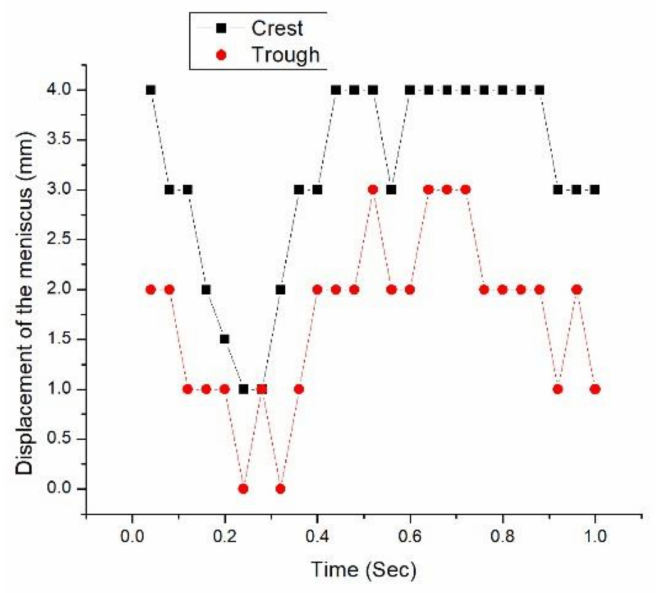
Figure 4. Displacement of meniscus at crest and trough in one second for 0 ◦ rectangular port nozzle.